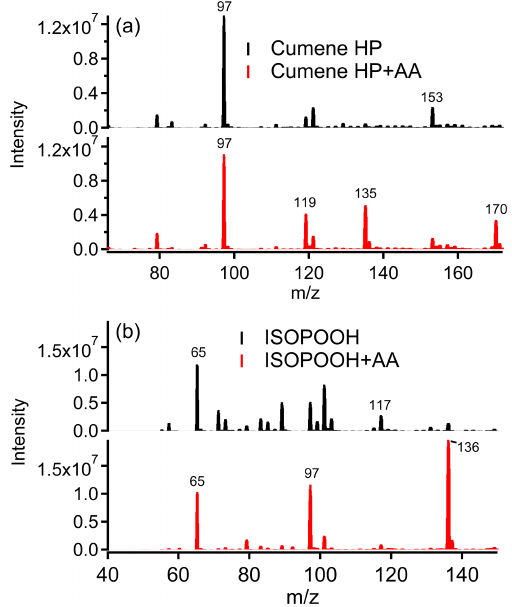
] + for (a) cumene HP and 4